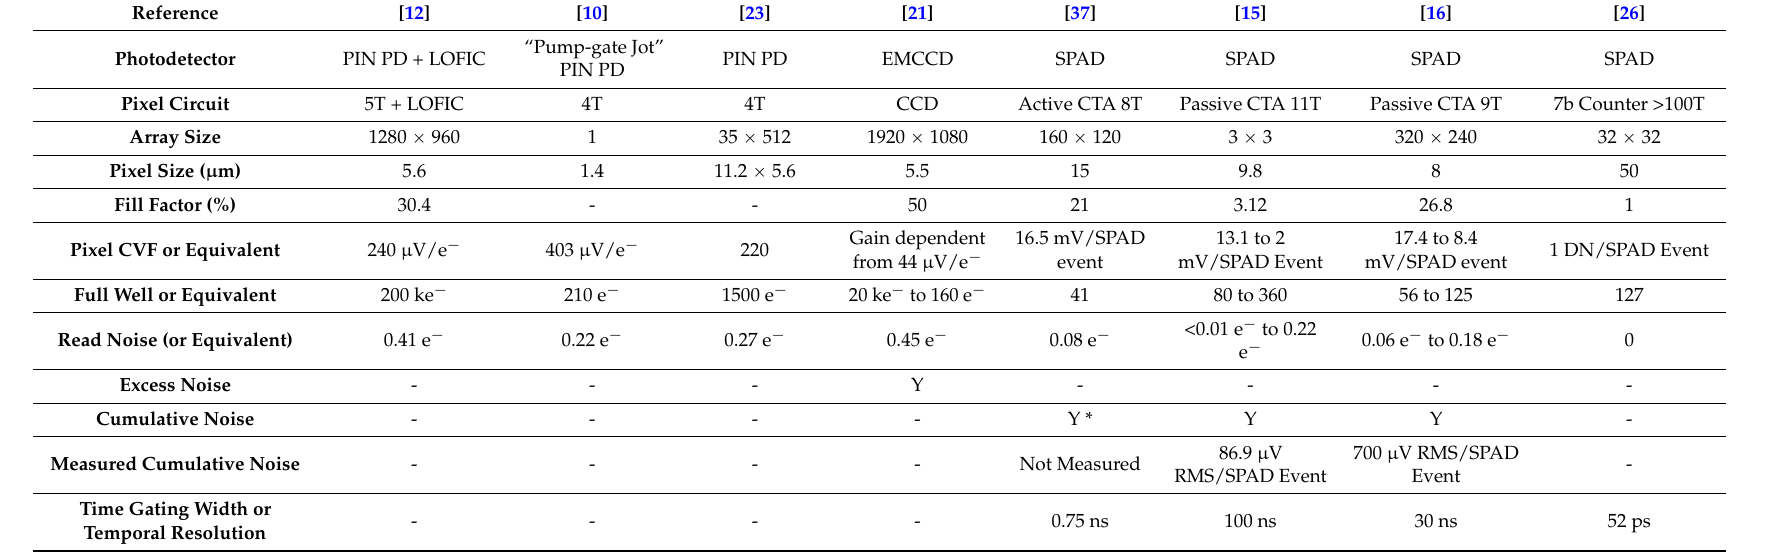
Table 4. Solid state single photon counting image sensor comparison